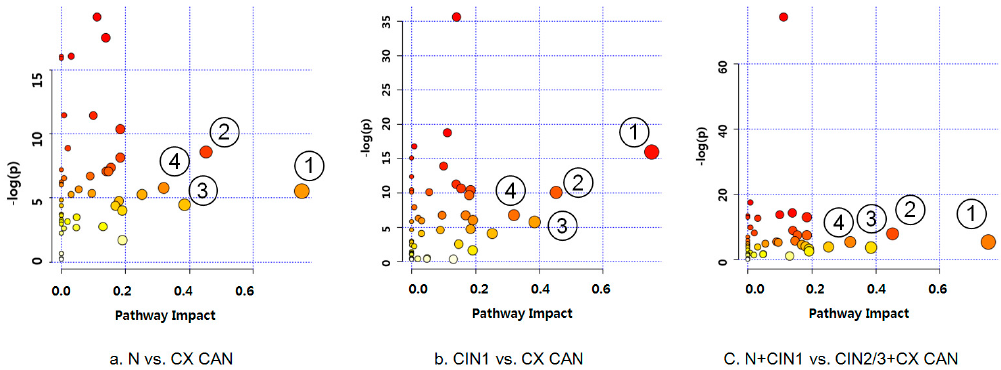
Figure 2. Metabolic pathway analysis in cervical carcinogenesis. Global pathway analysis was